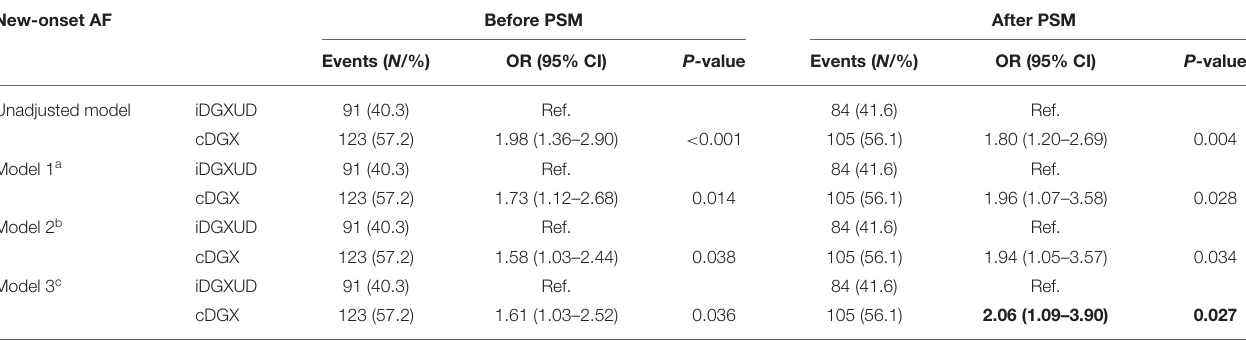
TABLE 5 | Association of DGX application methods with new-onset AF in RHD patients. New-onset AF Before PSM After PSM Events ( N /%) OR (95% CI) P -value Events ( N /%) OR (95% CI) P -value 91 (40.3) Ref. 84